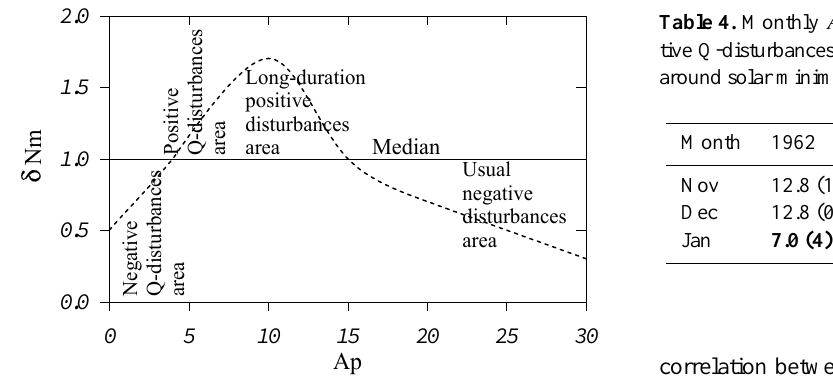
Fig. 3. A sketch to illustrate the place of Q-disturbances on the A p index scale.